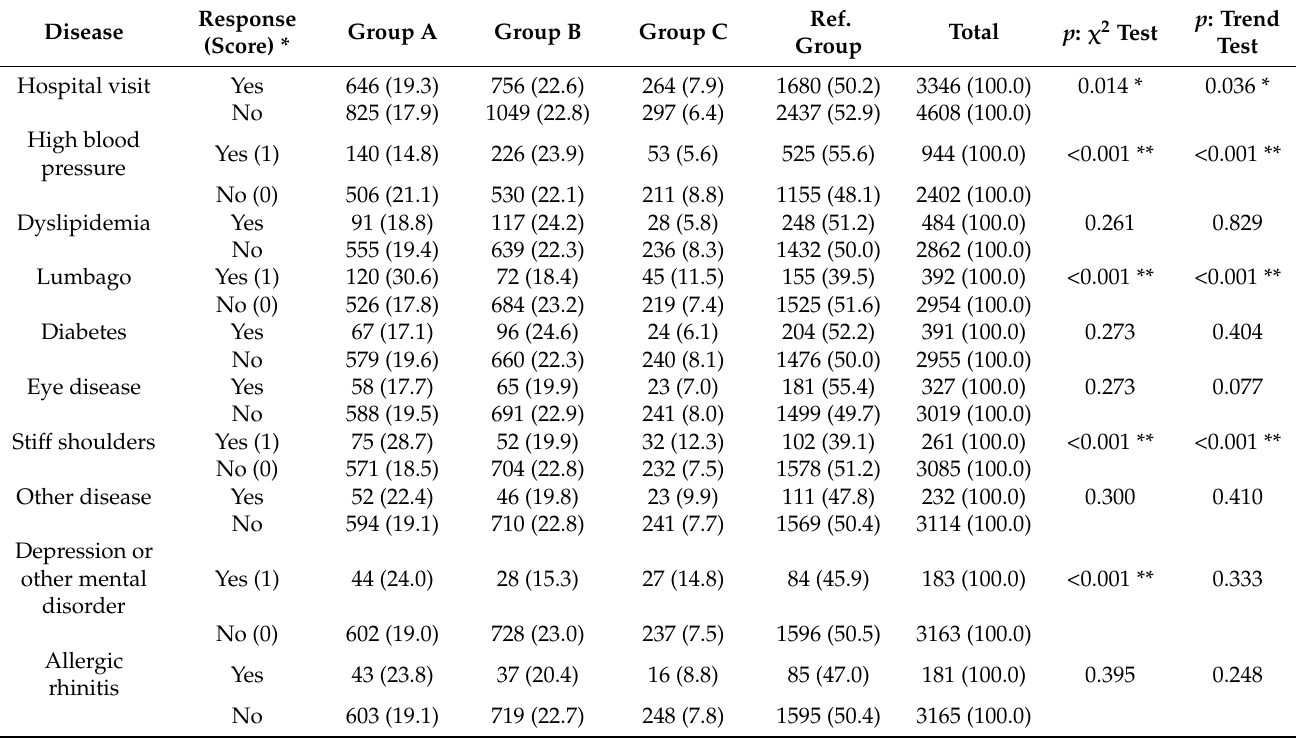
Table 4. Comparison of proportions of different injuries and diseases by sleep group.